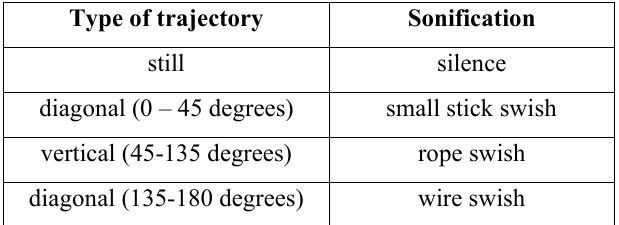
Table 1. Mapping examples between trajectory gestalts and sound families.